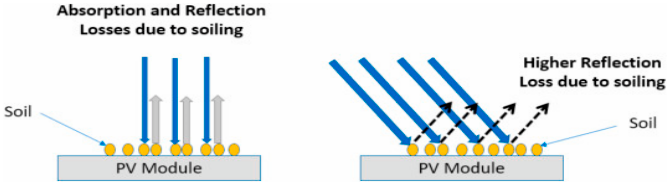
Figure 2. Impact of the angle of incidence on a soiled module